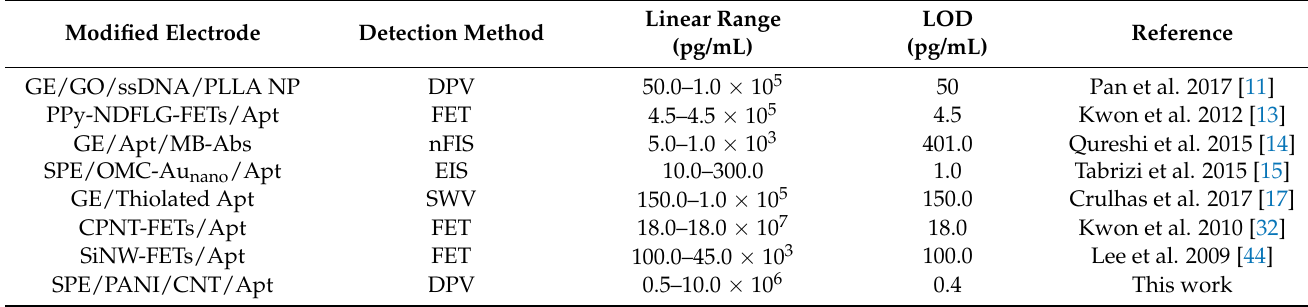
Table 1. Comparison of the VEGF sensor based on the nanomaterial-modified